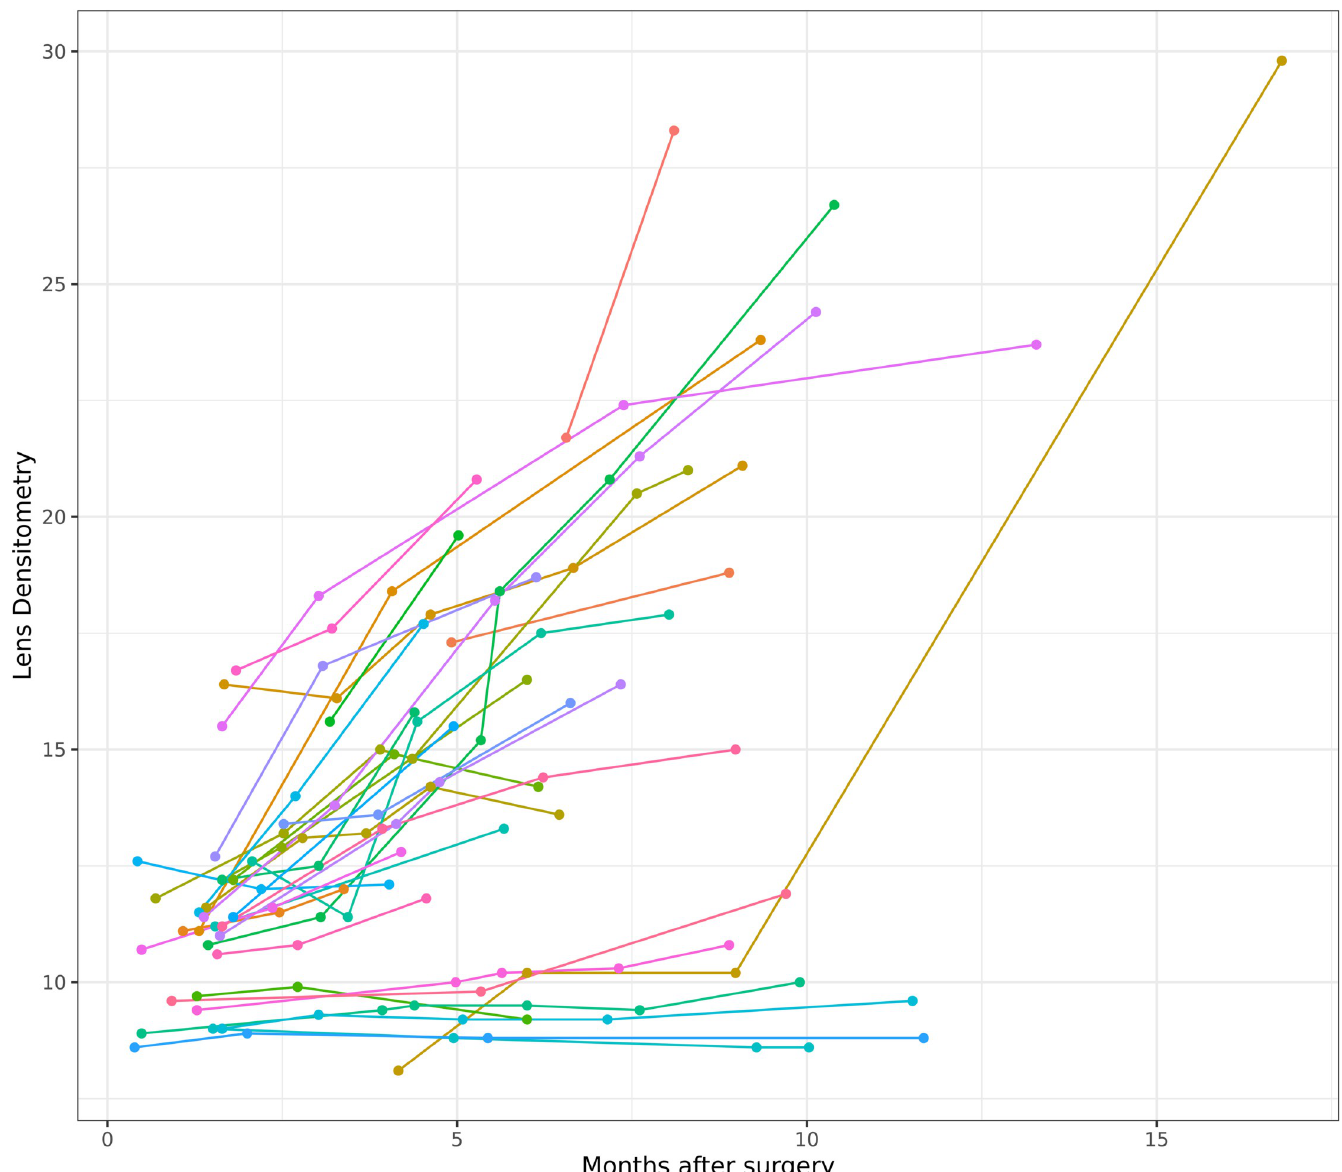
Fig 1. Changes in trajectories of lens densitometry. Trajectories of lens densitometry (%) during months after surgery for treated eyes.